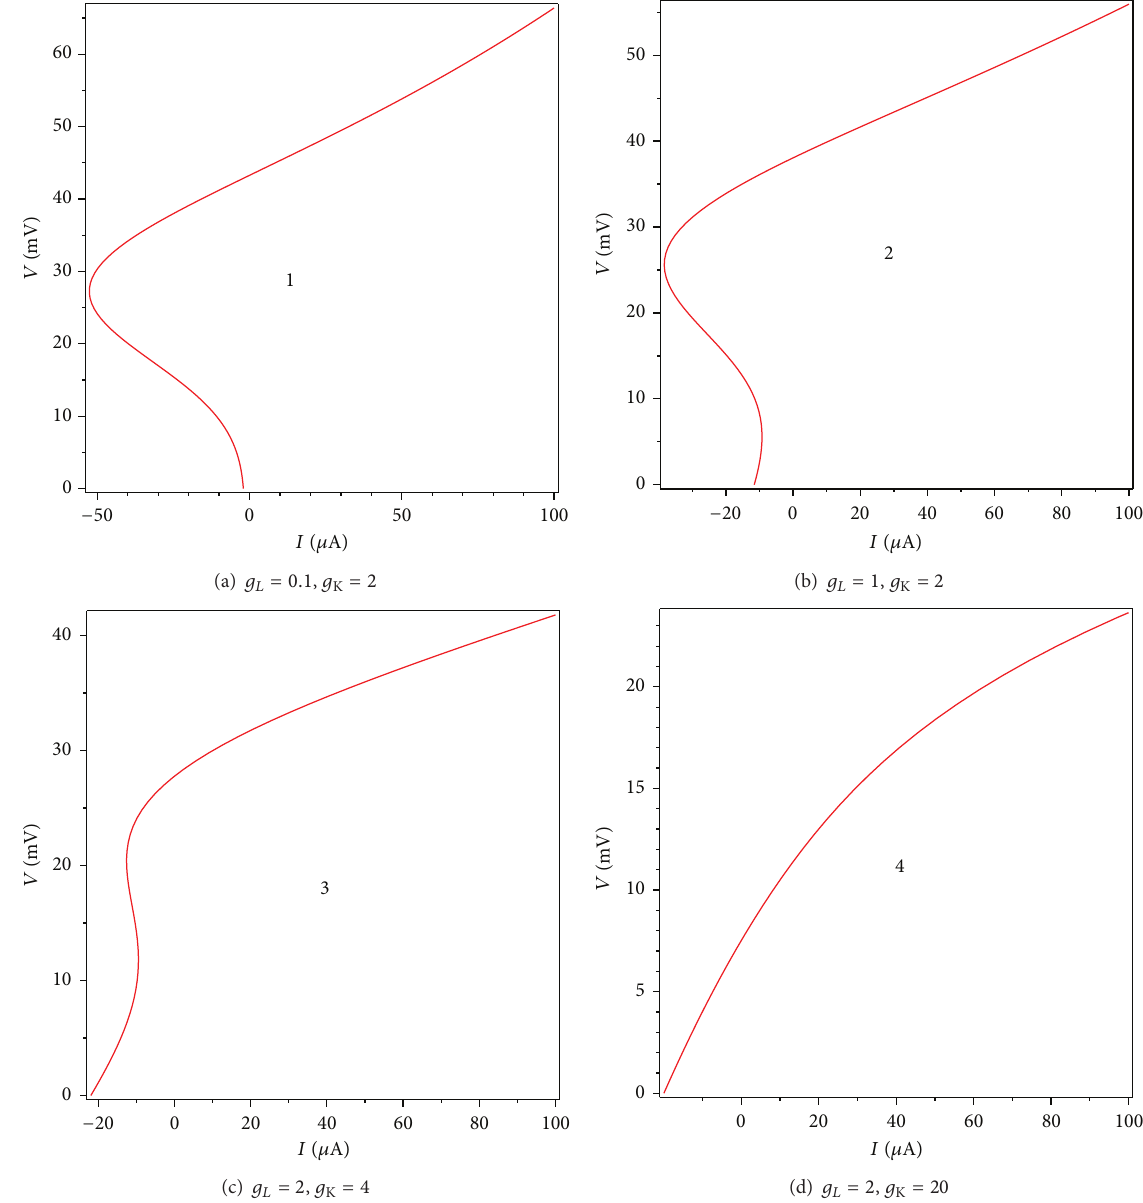
Figure 2: The bifurcation diagram for 𝑔 𝐿 , 𝑔